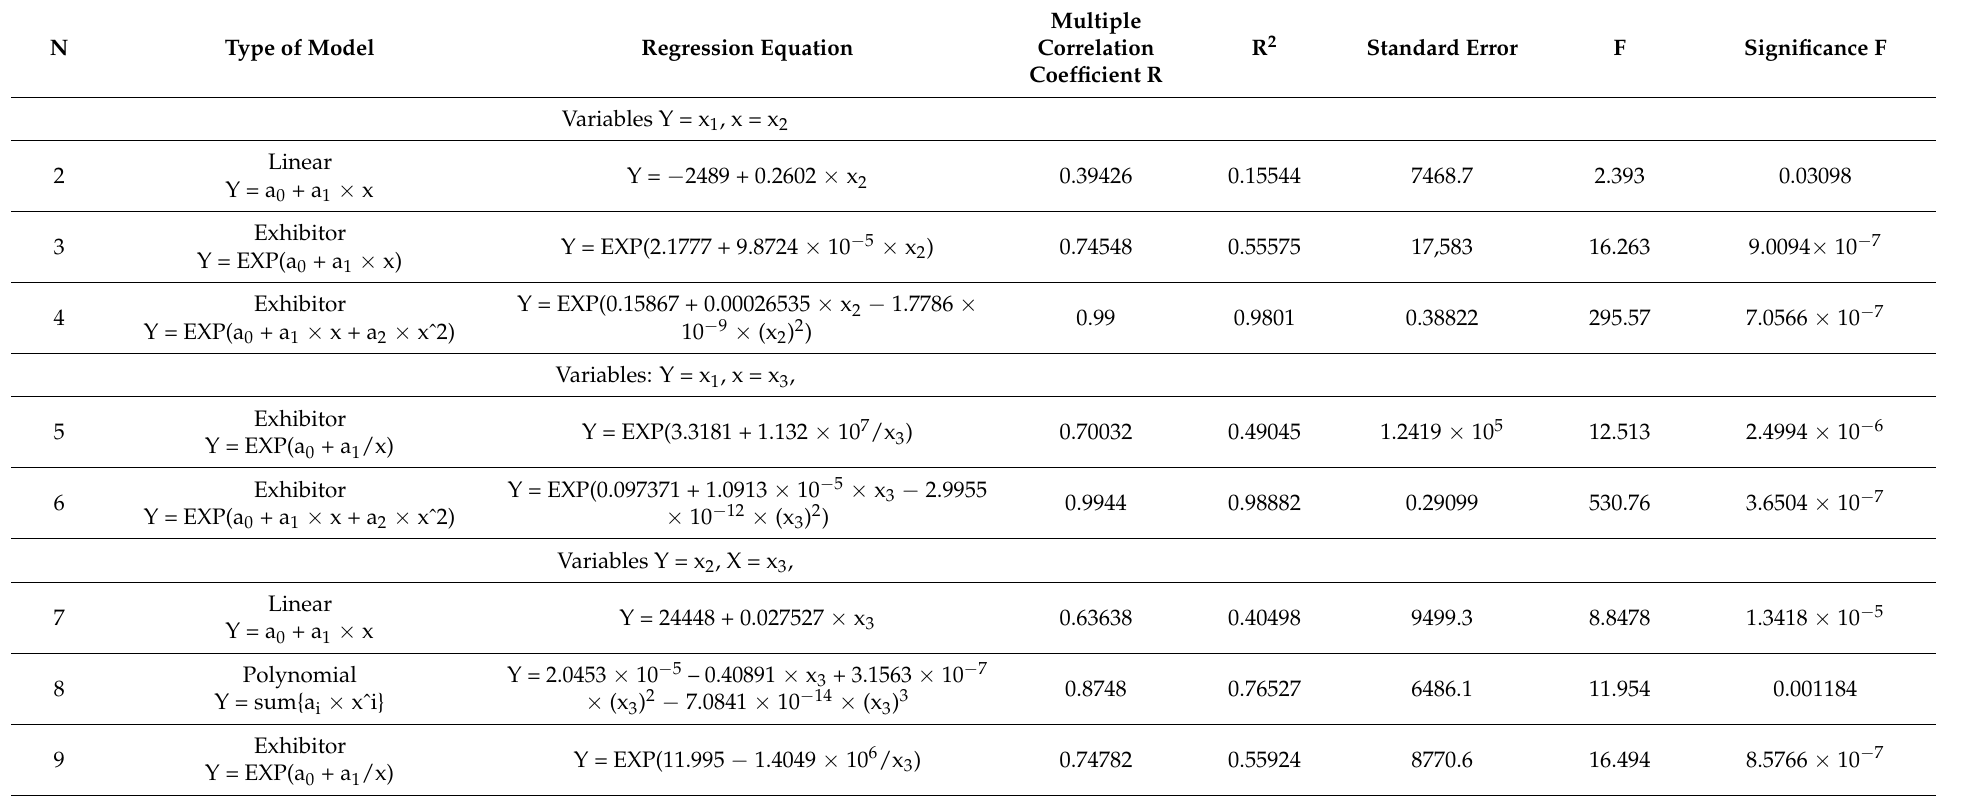
Table 1. Results of the regression analysis of the variables of the first cluster